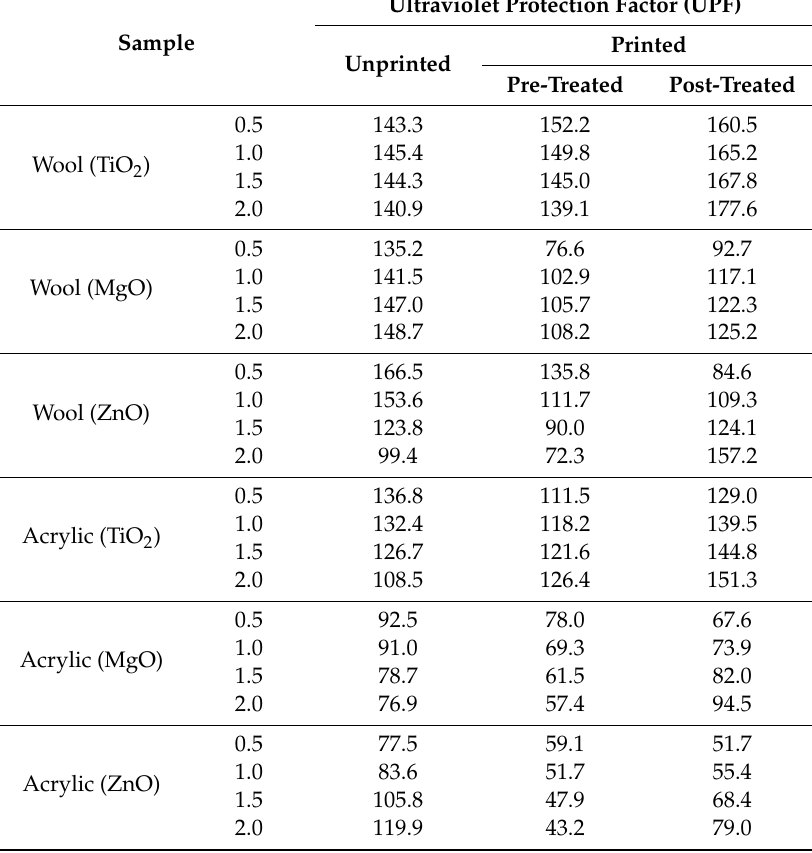
Table 8. Ultraviolet (UV) blocking of nanoparticles-immobilized unprinted and printed (pre- and post-treated) wool (acid dyestu ff and TGPLA thickener) and acrylic (basic dyestu ff and CLMA thickener) fabrics after